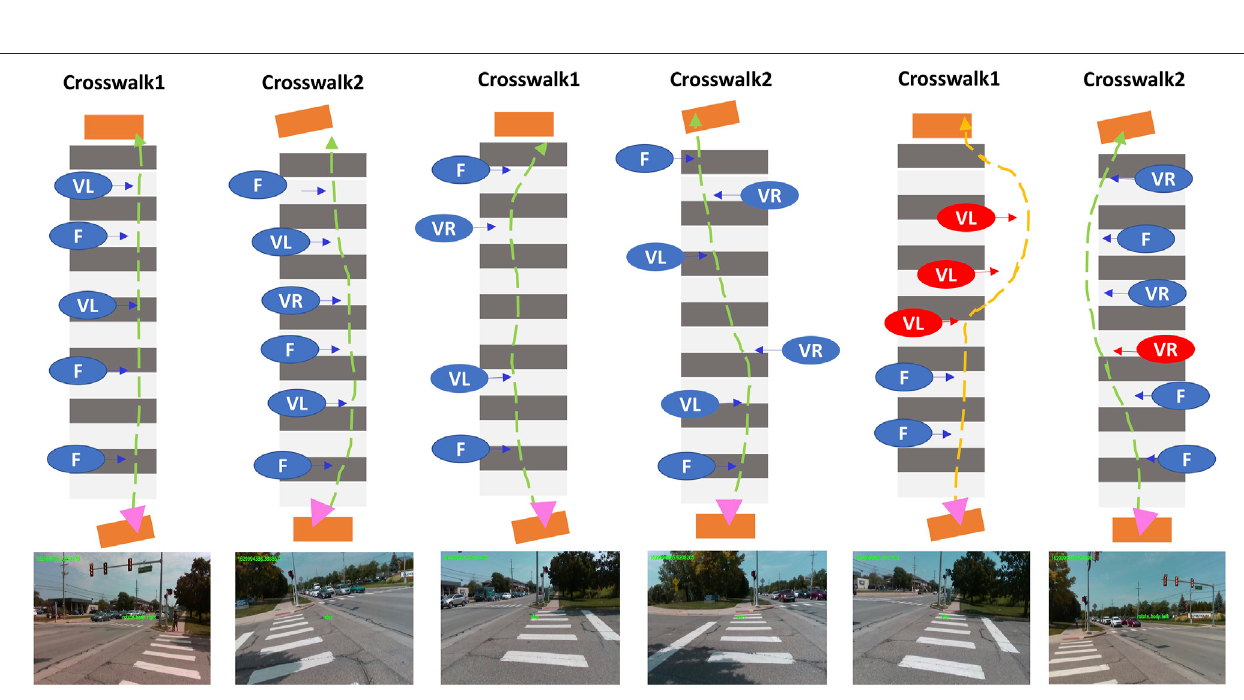
Frontiers in Electronics |